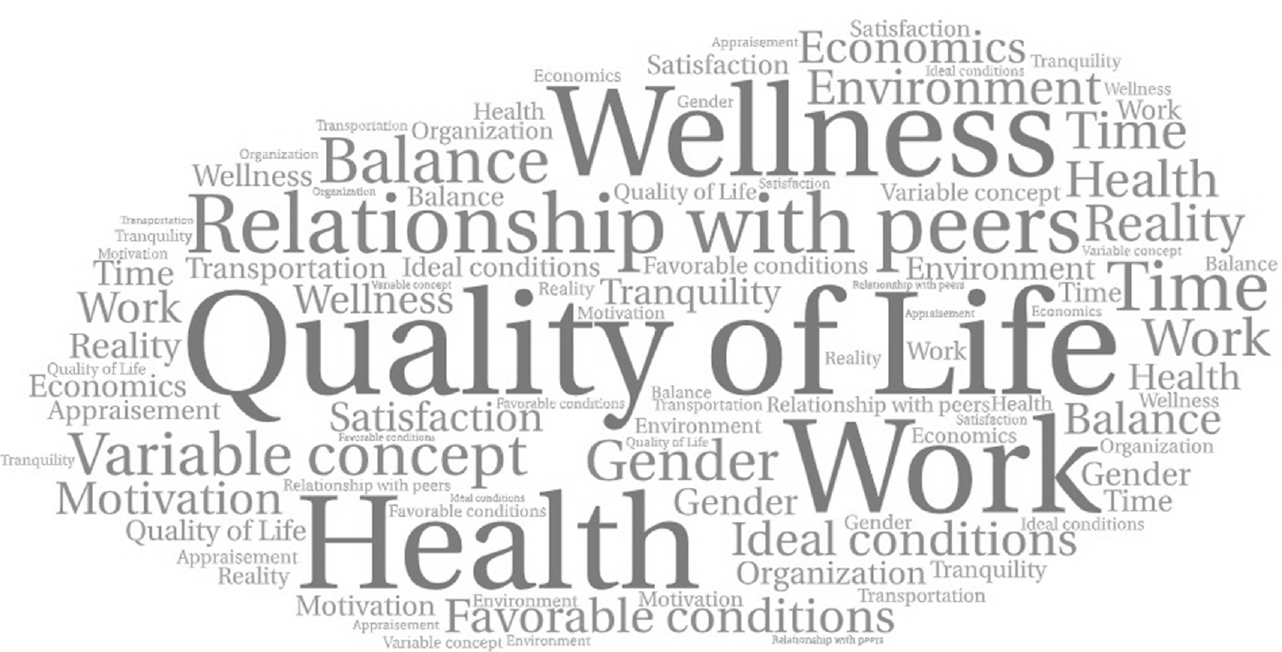
Figure 1. Word cloud for the concept of QOL according to the participants’ discourses. Elaborated by using wordart.com (free online tool: accessed on 5 October 2022).